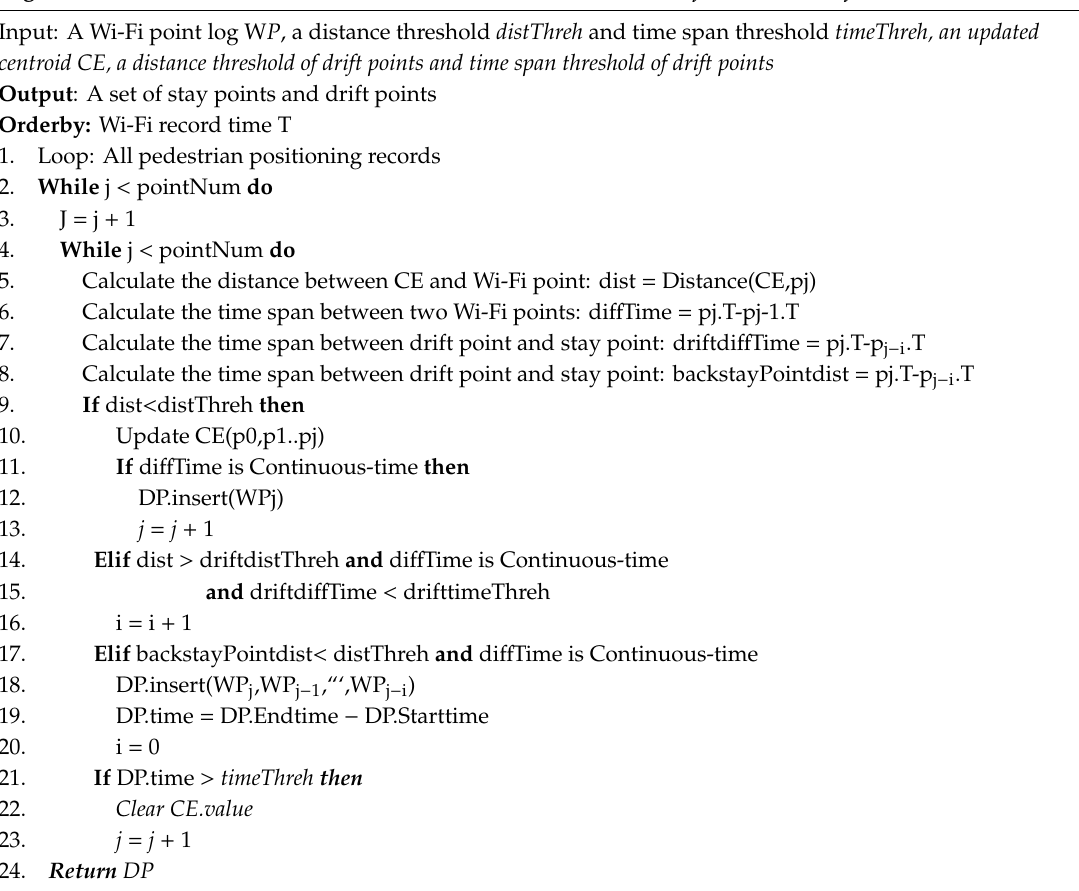
Algorithm 2 Drift Point Detection ( WP , distThreh , timeThreh , CE, driftdistThreh , drifttime , Threh